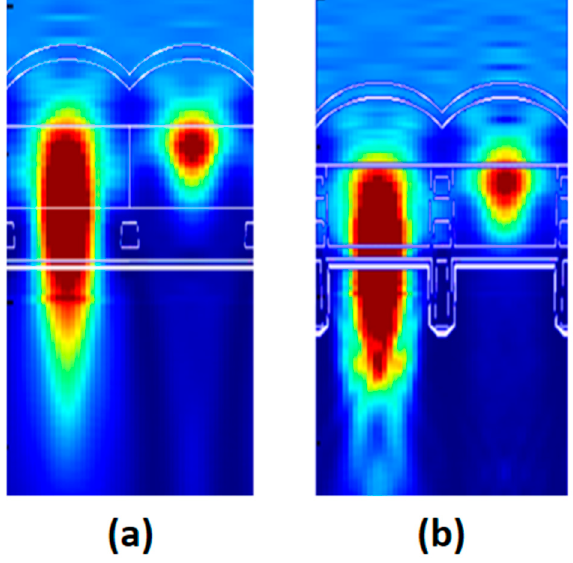
Figure 14. Optical simulation results at an incident wavelength of 530 nm. ( a ) Control pixel; ( b ) crosstalk-improved pixel.